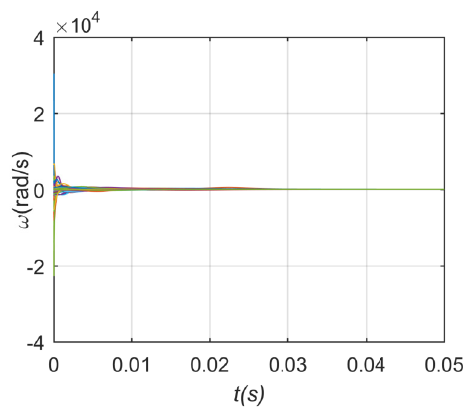
Figure 6. Frequency stabilization process of undirected network in case 1.